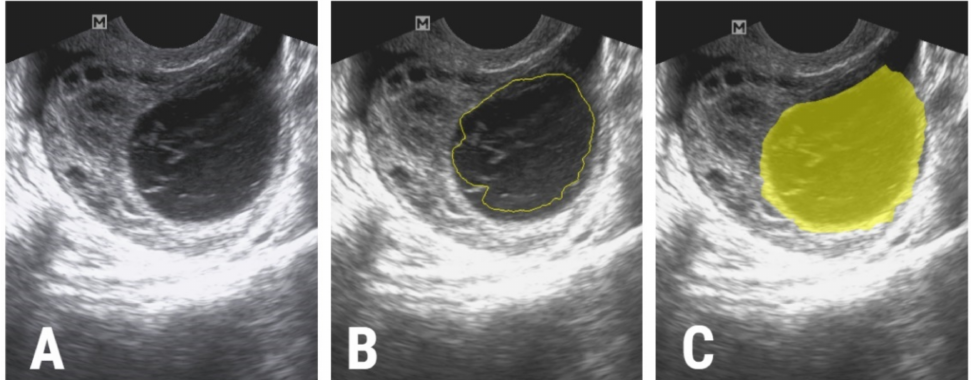
Figure 1. ( A ) The ultrasound image of a 29-year-old patient with s histologically proven hemorrhagic ovarian cyst, ( B ) the initial ROI that was automatically delineated by the software (yellow line), and ( C ) the final ROI after manual adjustments